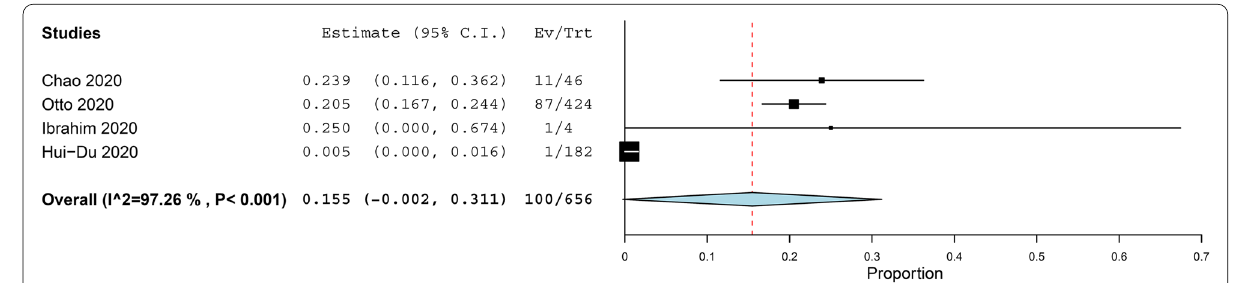
Fig. 3 The prevalence of asthma in young COVID‑19